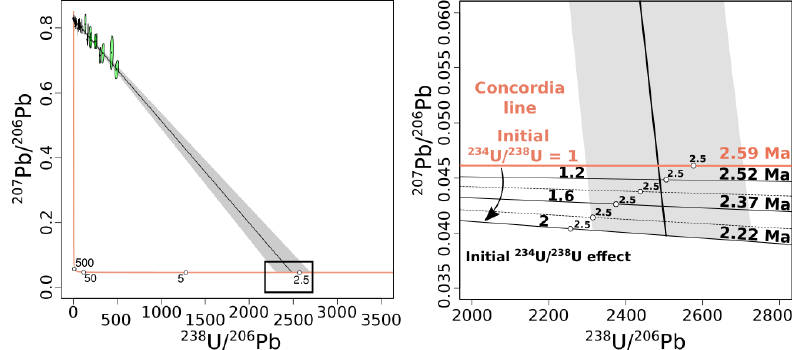
Figure 8. Impact of the initial 234 U excess on the final age estimation. Several initial 234 U / 238 U activity ratios have been tested ranging between 1 and 2. This spread in initial 234 U / 238 U leads to an age difference of 0.37Ma. The obtained U/P age of 2.59Ma, assuming equality of 234 U and 238 U contents, is thus a maximum age.